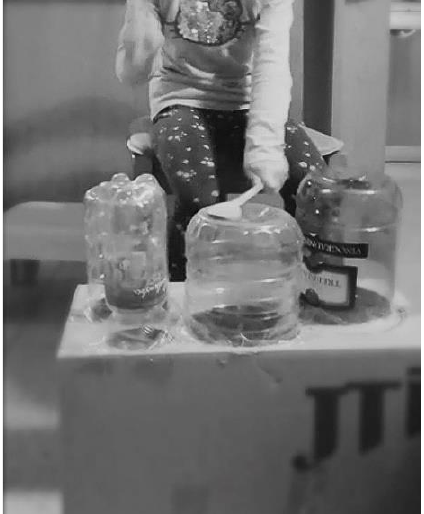
Figure 6. A clip from a video of a six-year-old pupil performing a rhythm task on her home-made rhythmic